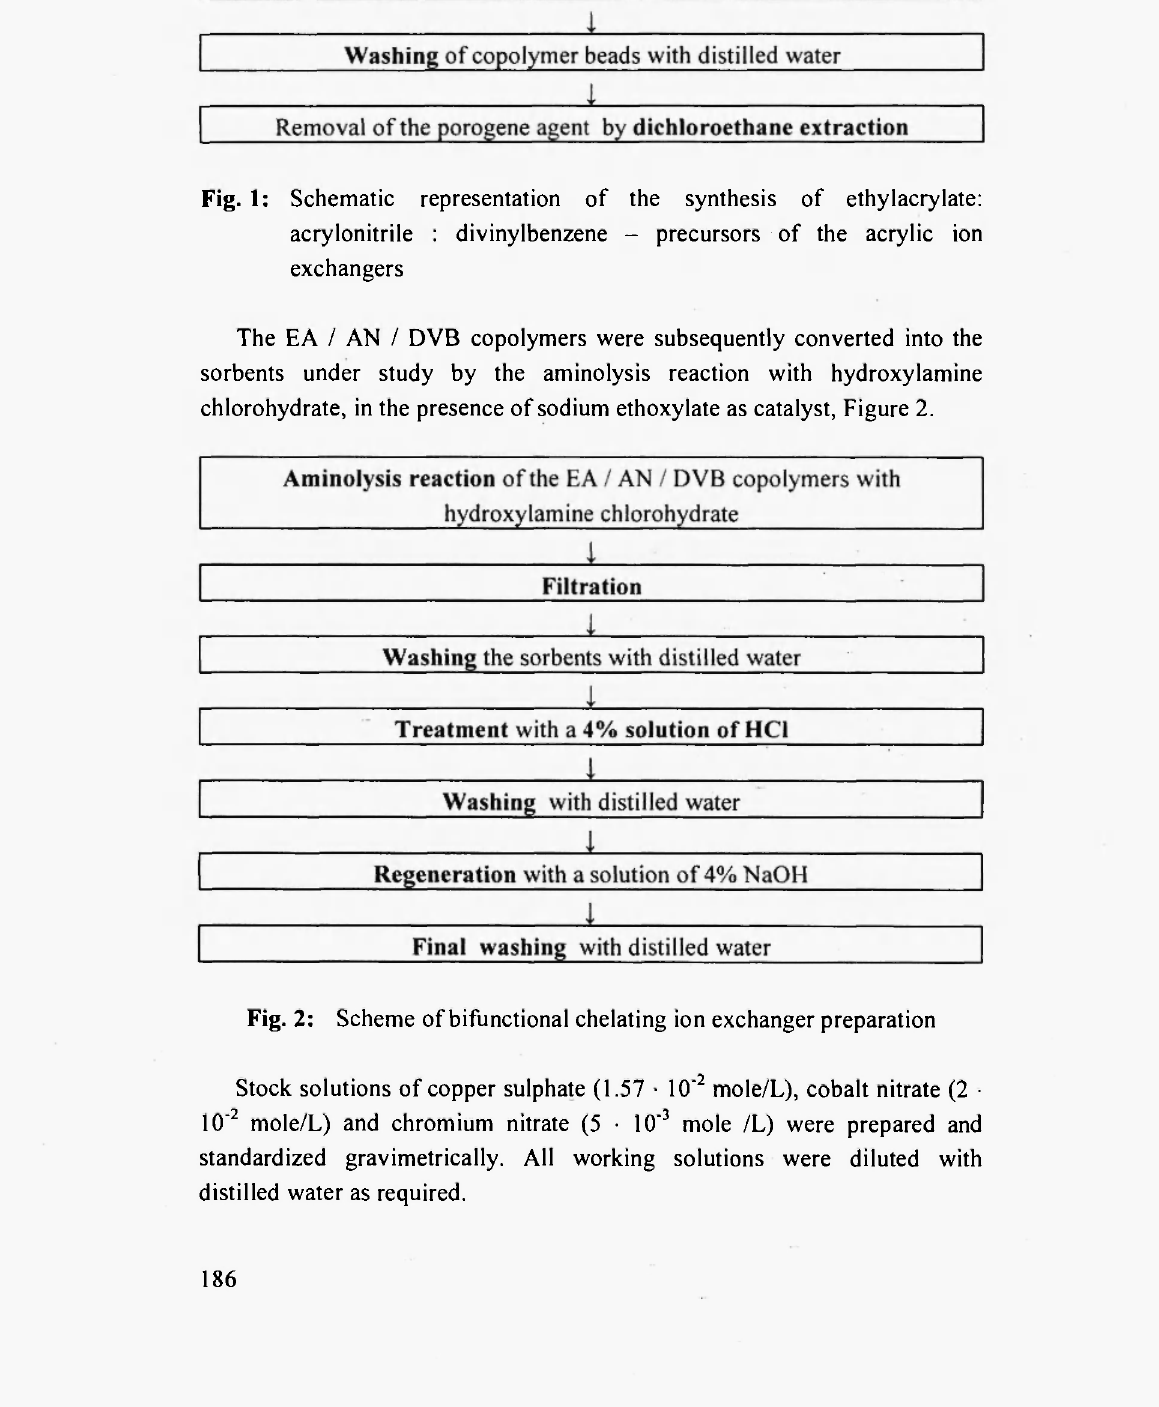
Fig. 1: Schematic representation of the synthesis of ethylacrylate: acrylonitrile : divinylbenzene - precursors of the acrylic ion exchangers